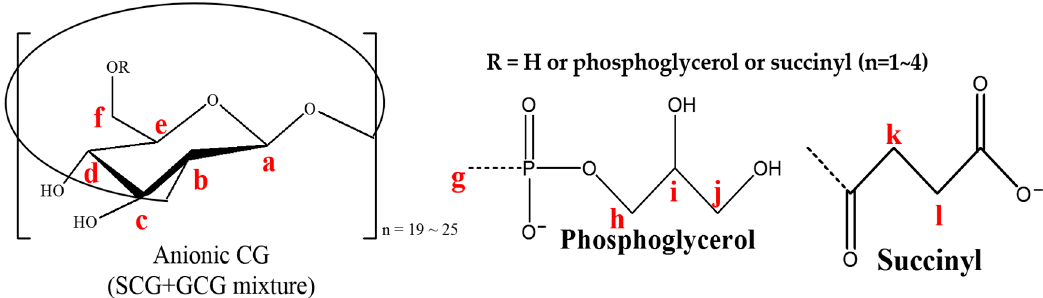
Figure 1. DEAE-Sephadex chromatography of neutral and anionic CG fractions from Sinorhizobium meliloti 1021.